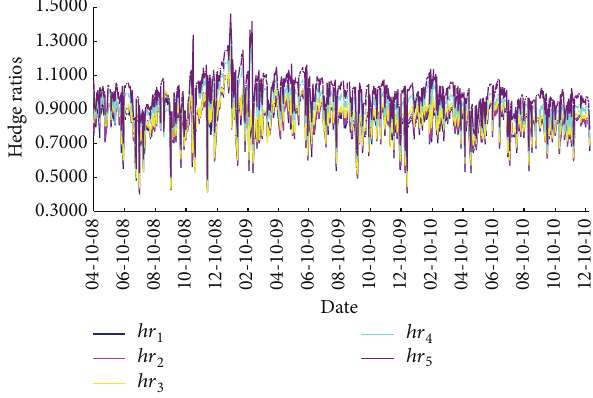
Figure 4: Conditional correlation coefficients between spot and futures with different maturities.